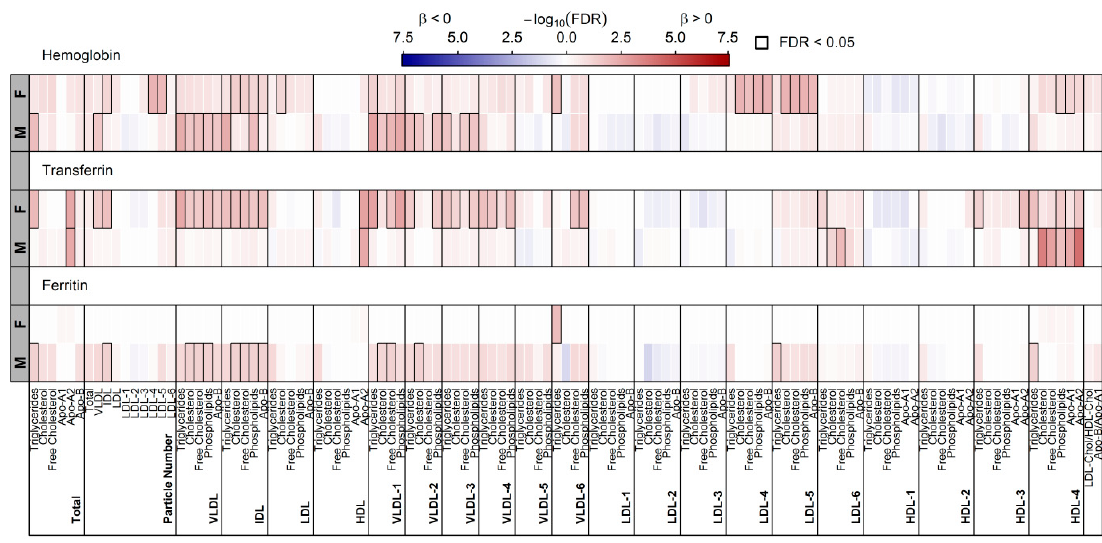
Figure 3. Heatmap of corrected p -values (controlling the false discovery rate (FDR) at 5%) from sex-specific (M—male; F—female) linear regression analyses using ferritin, transferrin, myoglobin and haemoglobin concentrations as exposure and lipoprotein particles as outcome. Models were adjusted for age, waist circumference, smoking behaviour, estimated glomerular filtration rate and serum alanine aminotransferase activity. Orange and blue shadings indicate positive and inverse associations, respectively. Thick frames indicate significant (FDR < 0.05) associations. VLDL = very low-density lipoprotein; LDL = low-density lipoprotein; IDL = intermediate-density lipoprotein; HDL = high-density lipoprotein; Apo = apolipoprotein.